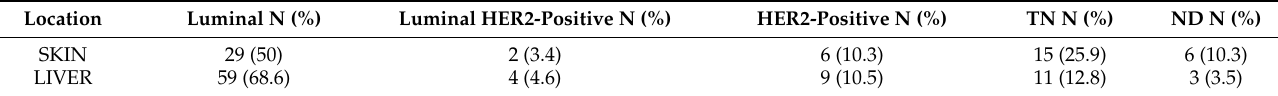
Table 3. Number of cases of metastasis in skin and liver grouped by